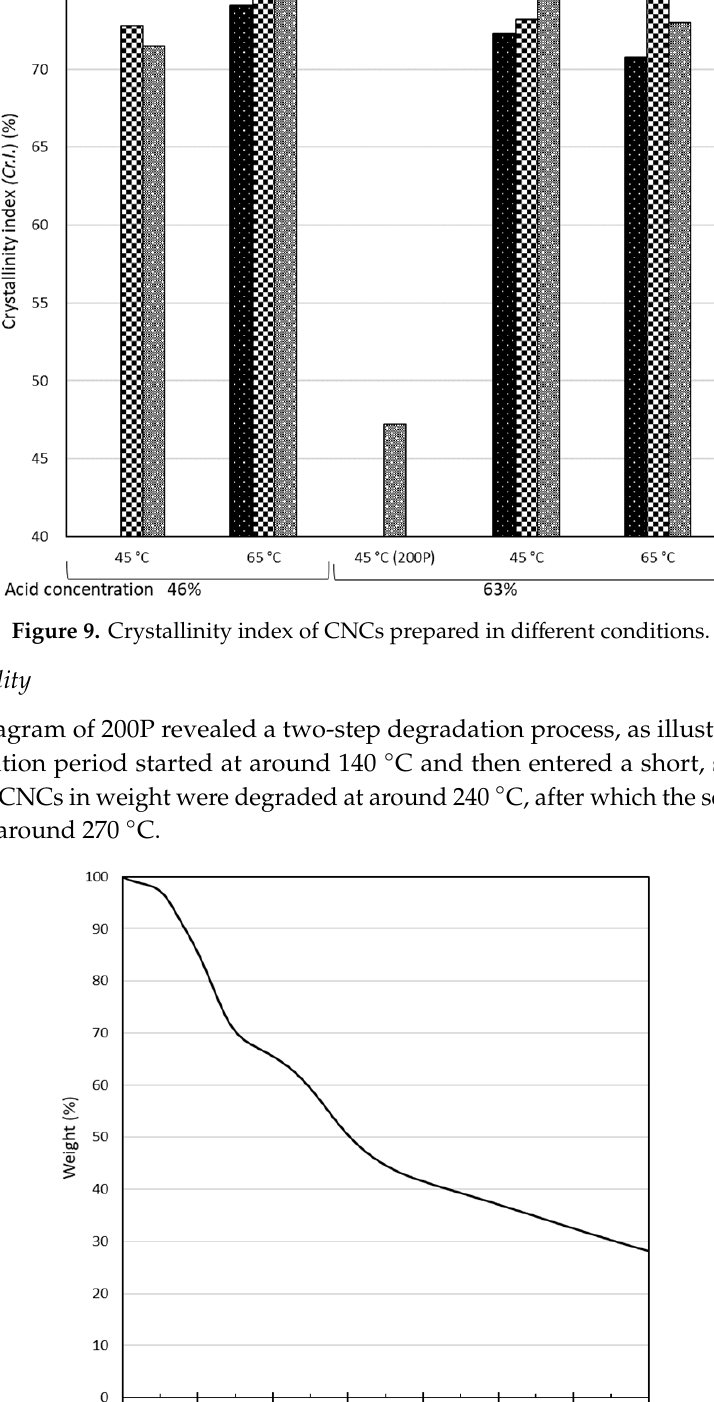
Figure 10. TGA diagram of sample “200P”.